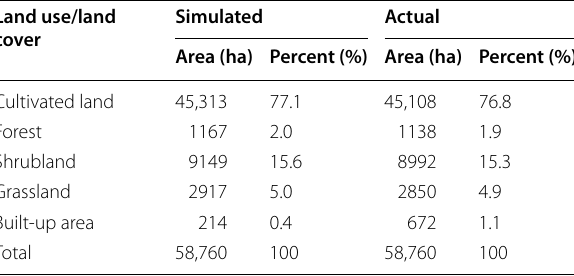
Table 10 The simulated and the actual land use/land cover area (ha) of the Andassa watershed in